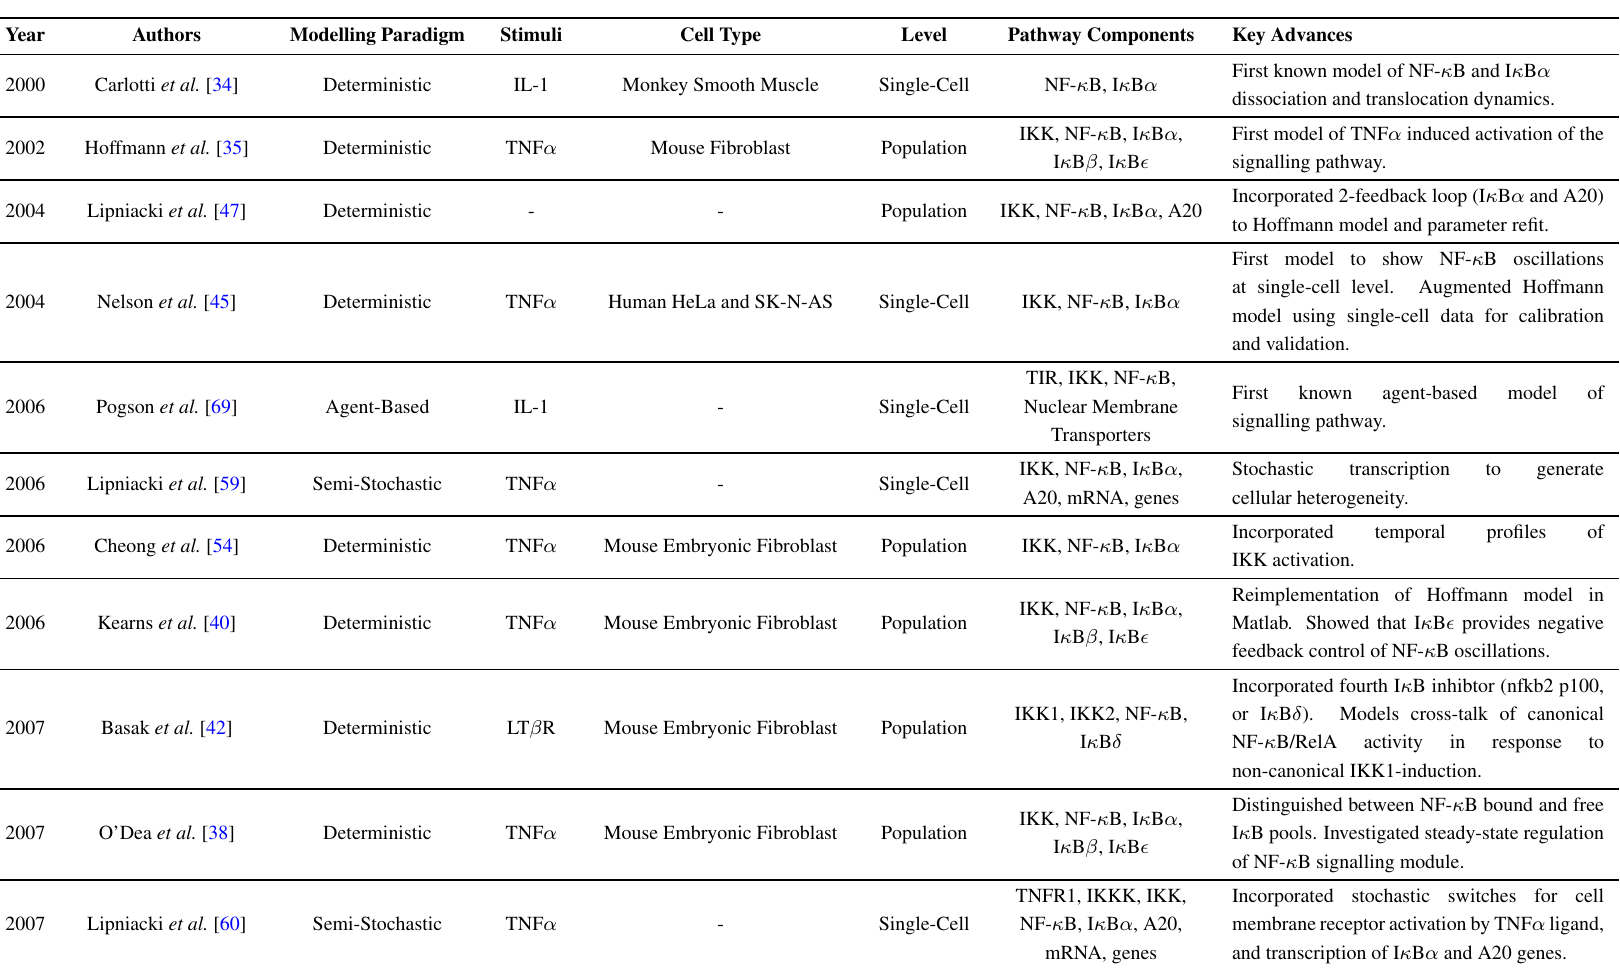
Table 1. The top 20 computational models (in chronological order) that we believe have facilitated increased understanding of the NF- κ B signalling pathway. Along with the year of journal article publication, we have also documented: the modelling paradigm used (deterministic, semi-stochastic, or agent-based), the specific extracellular stimulus (if any), the specific cell type (if any), the hierarchical level of the model (single-cell or population), the pathway components that were explicitly modelled, and the key advances of the